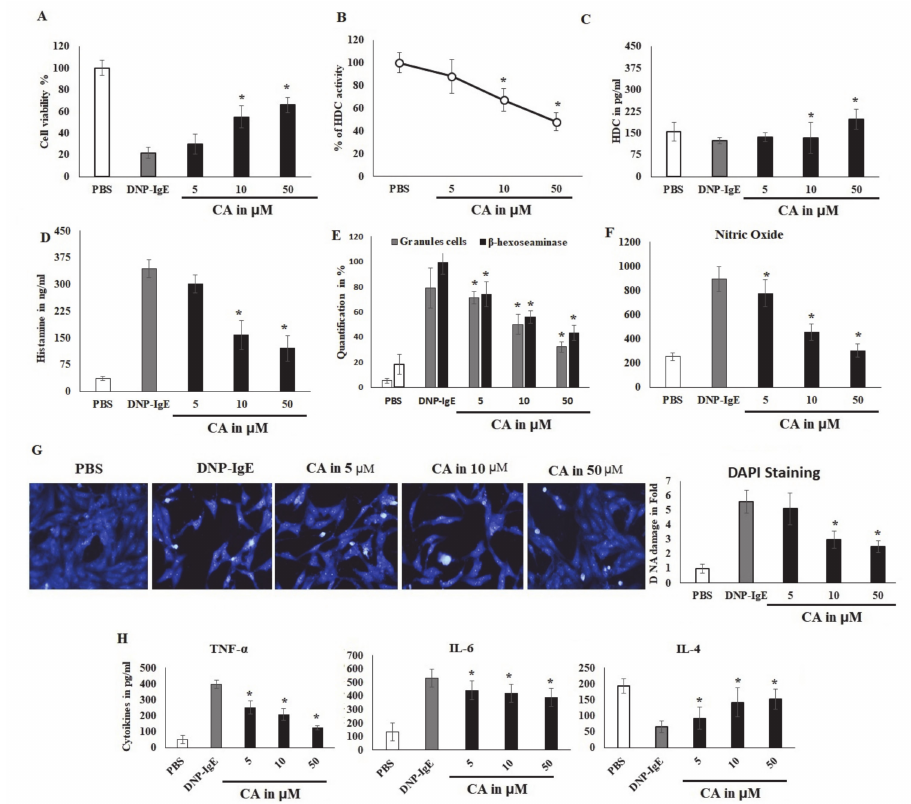
Figure 4. E ff ects of cinnamaldehyde (CA) on the cell viability and HDC activity. ( A ) Viability of untreated RBL-2H3 cells incubated with CA for 24 h quantified by -(4,5-dDimethylthiazol-2-yl)-2,5-diphenyltetrazolium bromide (MTT) assay compared with IgE sensitization controls. ( B , C ) An analysis of the inhibition of HDC activity by CA treatment and the quantification of HDC using RBL-2H3 cells in in vitro IgE-mediated allergic reactions with various concentrations of CA. ( D ) The e ff ect of CA on the percentage of histamine quantification in RBL-2H3 cells values, expressedasng / mLofhistamineinthemedium. ( E )AnalysisoftheCAe ff ectonthepercentageof cellular granules and degranulation markers (Hexoseaminidase) in stimulated RBL-2H3 cells examined and counted under a high-power phase contrast microscope. ( F ) Nitric oxide quantification using the reductionofgreissreagentsandvaluesareobservedat402nm. ( G )Anti-apoptoticresultsonthee ff ectsof CA on DNA integrity and strand degradation imaging using florescence 4',6-Diamidino-2-Phenylindole (DAPI) staining dye. DNA damage was quantified with arbitrary units of silver blue color and recorded as arbitrary units. ( H ) The e ff ect of CA on the cytokine expression in DNP-IgE stimulated RBL-2H3 cell lines. Cytokines such as TNF- α , IL-6, and IL-4 were quantified and expressed as pg / mL. Data are shown as the mean ± S.D. of representative experiments out of three independent experiments performed in triplicate and yielding similar results. (* p <